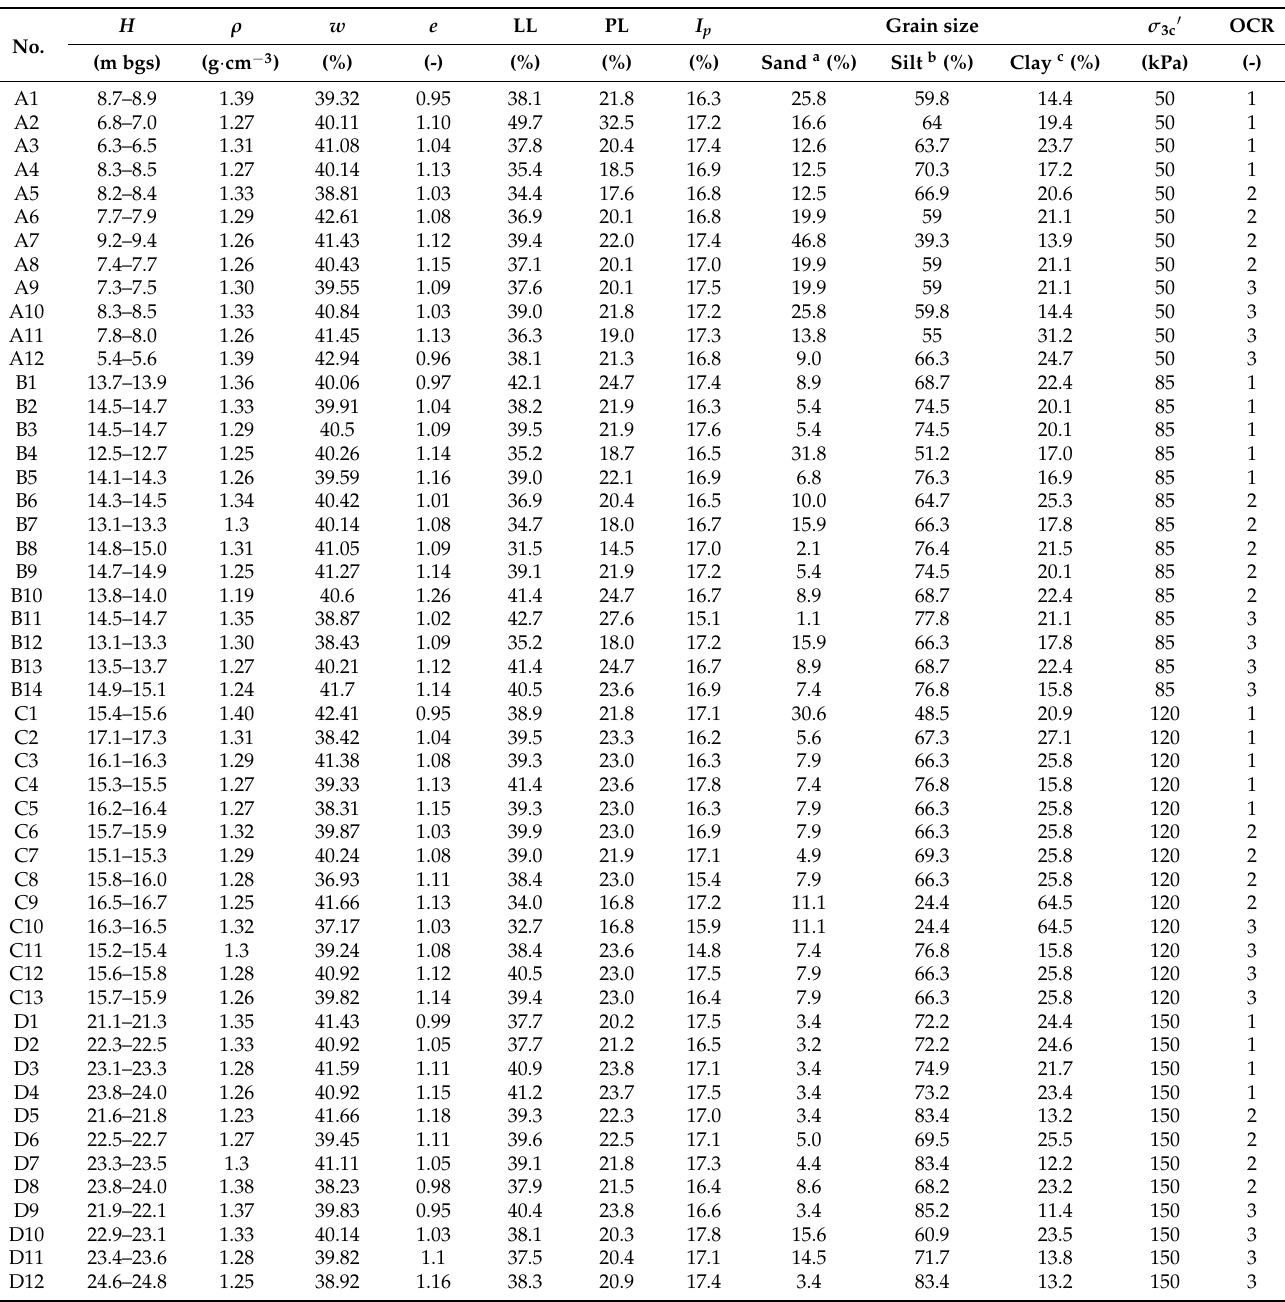
Table 1. Basic physical properties of test soil